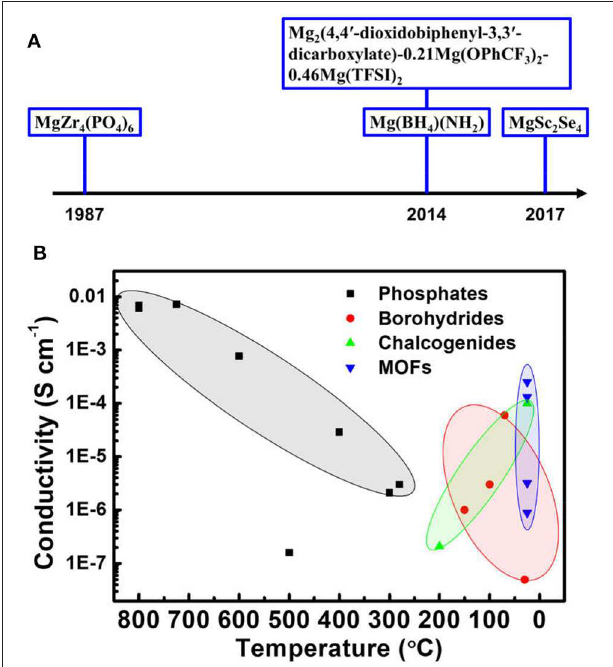
FIGURE 2 | A timeline of key development of Mg ion solid conductors (A) and a summary of the ionic conductivities of various solid conductors as a function of temperature in the report (B)